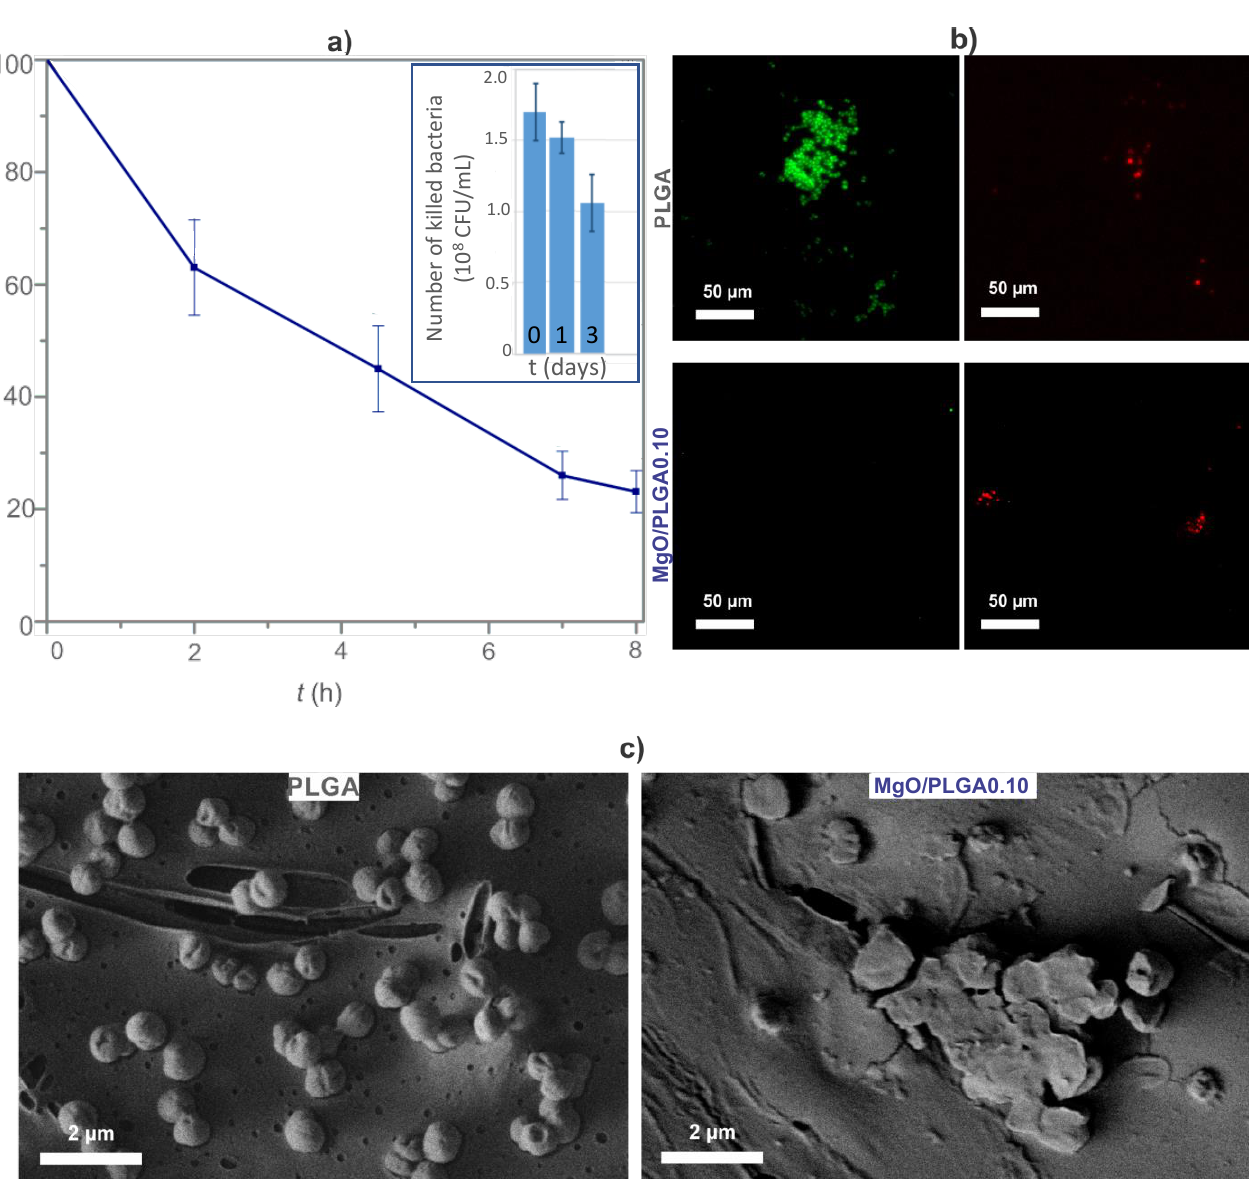
Figure 6. ( a ) The decrease in planktonic E. coli viability upon exposure to the MgO/PLGA0.10 composite coating; the decrease in bactericidal potential of the MgO/PLGA0.10 composite coating due to preceding exposure to physiological solution for either one or three days (chart insert); ( b ) survivability of S. epidermidis bacteria colonizing PLGA and MgO/PLGA0.10 coatings by BacLight live/dead fluorescent imaging; ( c ) SEM imaging of bacteria colonizing PLGA and MgO/PLGA0.10 coatings.